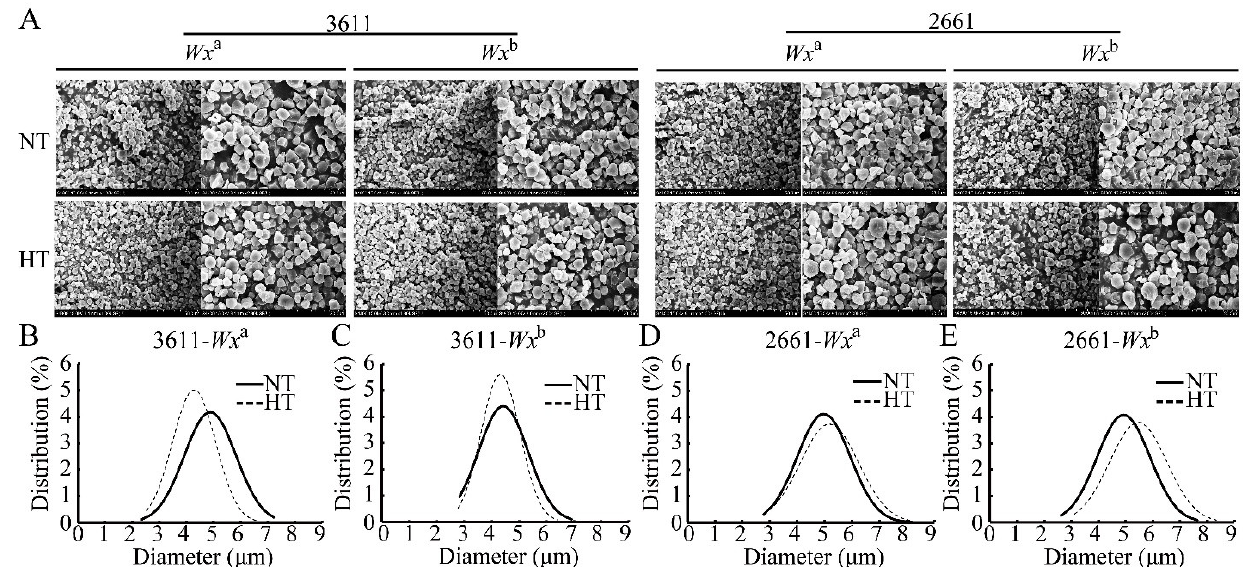
Figure 4. Observation and analysis on the starch granules of different Wx NILs under different temperature conditions. ( A ) SEM observation on the starch granules from four rice materials planted under different temperature conditions. ( B – E ) The influence of high temperature on the starch granule size distributions different Wx NILs. “NT” stands for normal condition and “HT” stands for high-temperature condition.